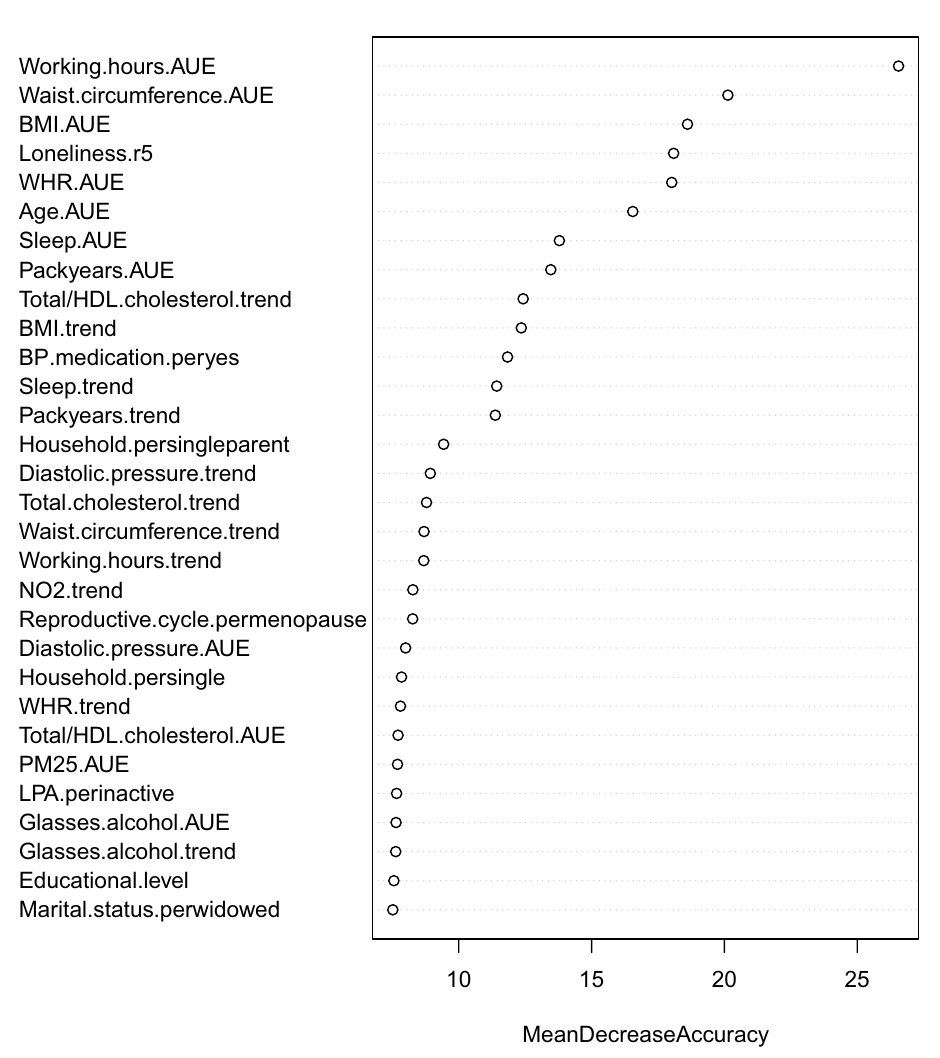
Figure 4. Variable importance ranking of the 30 most important exposures in predicting self-perceived health. The x-axis displays the mean decrease in accuracy that occurs when a particular exposure is permuted randomly in the random forest. AUE, Area-Under-the-Exposure; BMI, body mass index; BP, blood pressure; LPA, leisure time physical activity; r5, round 5; trend, Trend-of-the-Exposure; WHR, waist/hip